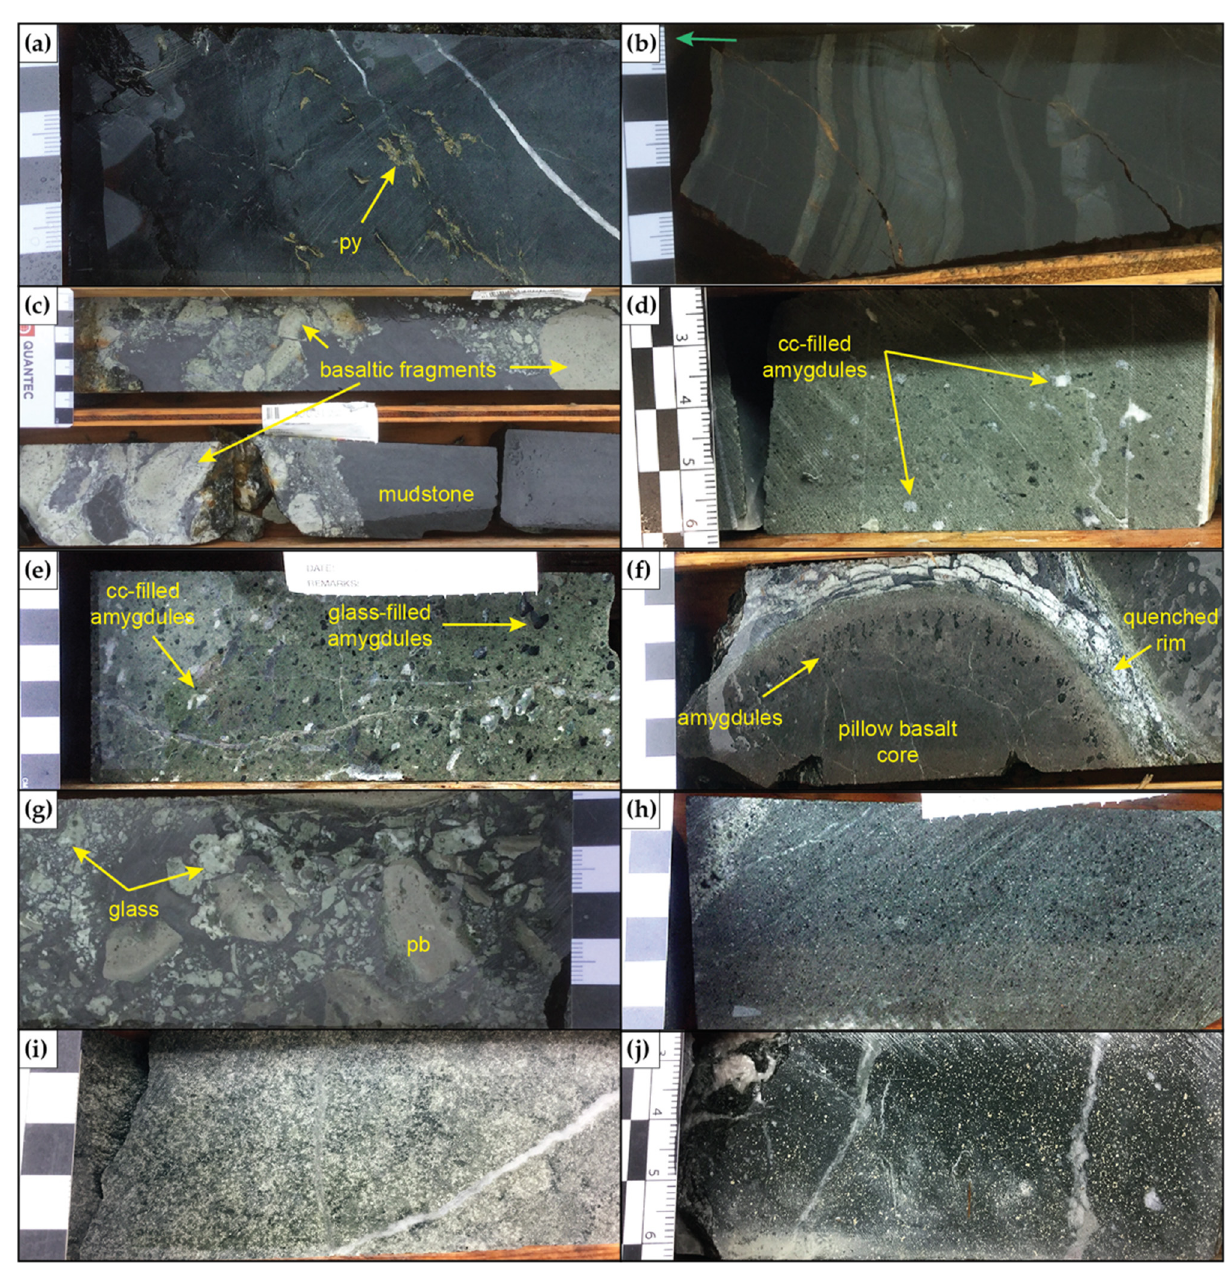
Figure 6. Igneous and epiclastic lithologies at the A6 Anomaly—Part II, ( a , b ) Mudstone, ( a ) Massive mudstone with disseminated pyrite and fine pyrite stringer crosscut by carbonate veinlets (BR-35), ( b ) Banded mudstone (dark) with finely bedded siltstone beds (grey); green arrow depicts stratigraphic up (BR-35), ( c ) Peperite, emplacement of aphanitic basalt into mudstone (BR-38), ( d ) Amygdaloidal basaltic flow (Group B basalt) with glass and calcite-filled vesicles (BR-82), ( e ) Amygdaloidal basaltic flow (Group A basalt) with glass and calcite-filled vesicles (BR-35), ( f ) Pillow basalt (Group A basalt) with amygdules along margins and quenched rim (BR-35), ( g ) Hyaloclastite with angular basaltic glass fragments in aphanitic grey matrix (BR-35), ( h ) Moderately phaneritic dolerite dyke (dyke I-a, BR-35), ( i ) Fine phaneritic dolerite dyke with cumulus texture (dyke I-b, BR-84), ( j ) Very fine-grained dolerite dyke (dyke II, BR-82). Abbreviations: cc—calcite, pb—pillow basalt, py—pyrite.